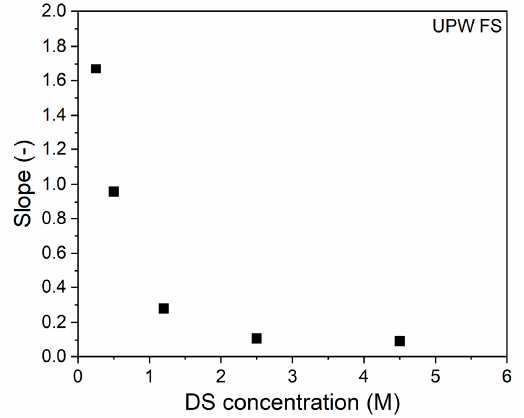
Figure 2. Slopes of the water flux vs. osmotic pressure difference between bulk DS and FS at each DS concentrations. FS: UPW.